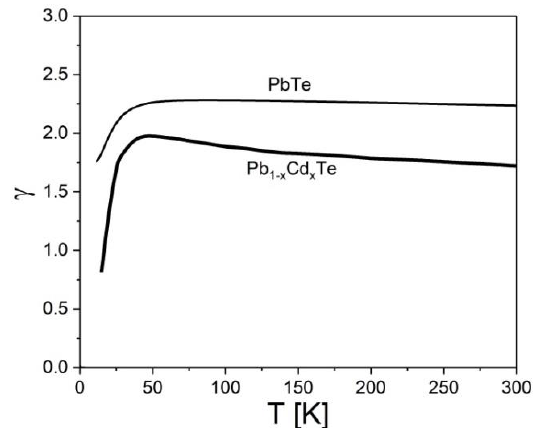
Figure 7. The temperature variation of the Gr ü neisen parameter for PbTe and Pb 0.884 Cd 0.116 Te in the ranges 10-300 K and 15 – 300 K, respectively. The thin and the thick lines refer to PbTe and the ranges 10–300 K and 15–300 K, respectively. The thin and the thick lines refer to PbTe and Pb 0.884 Cd 0.116 Te, respectively. Pb 0.884 Cd 0.116 Te,